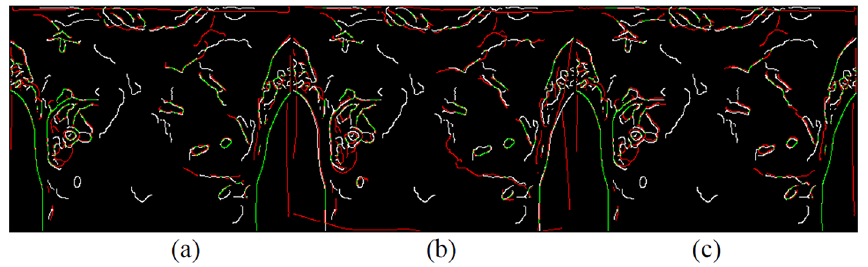
Figure 11. Canny overlays of TYPE III images obtained with ( a ) the proposed ( b ) Lee et al . ( c ) Optical flow.